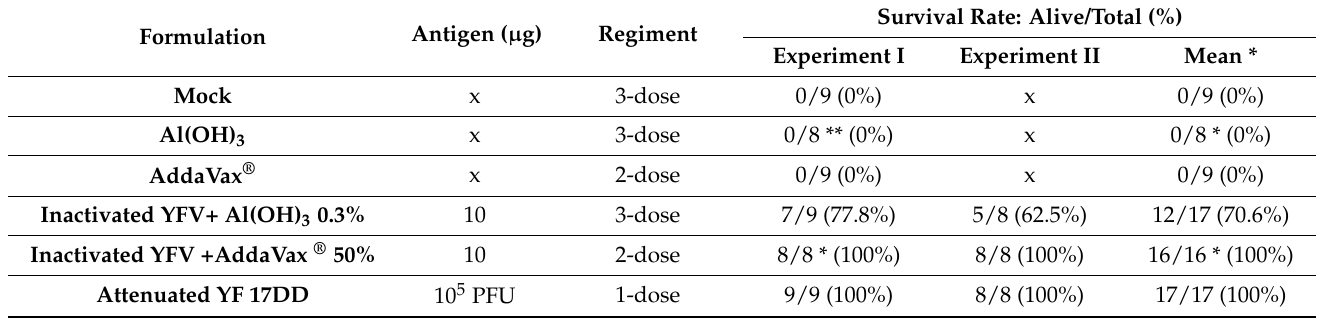
Table 1. Survival rates of mice immunized with different adjuvant formulations of inactivated YF 17DD